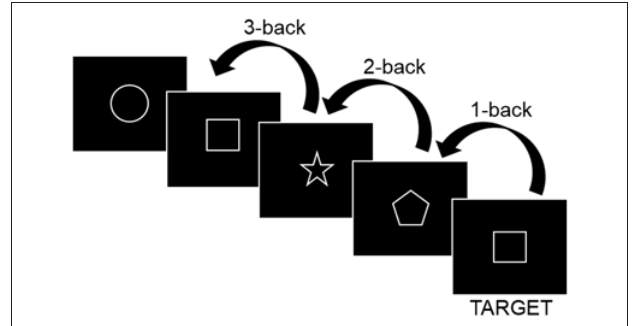
FIGURE 1 | Figural three-back task. A target constitutes a shape that is the same as the shape presented three steps back in the